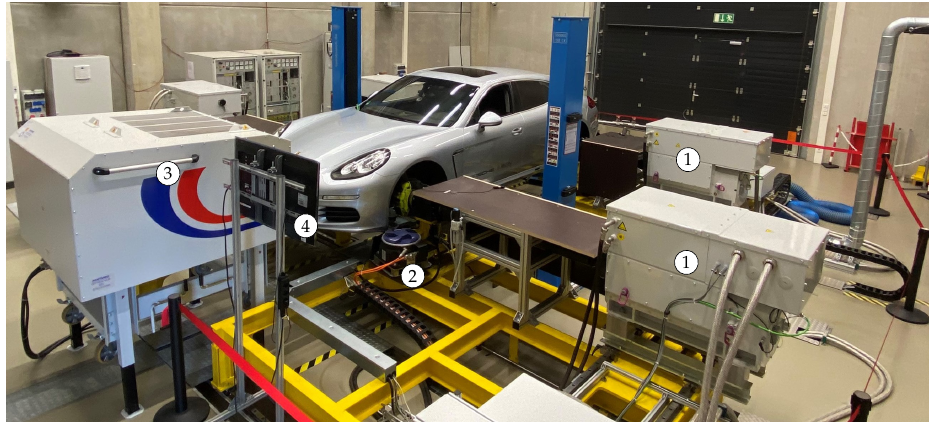
Figure 2. The Vehicle-in-the-Loop Test Bench of the